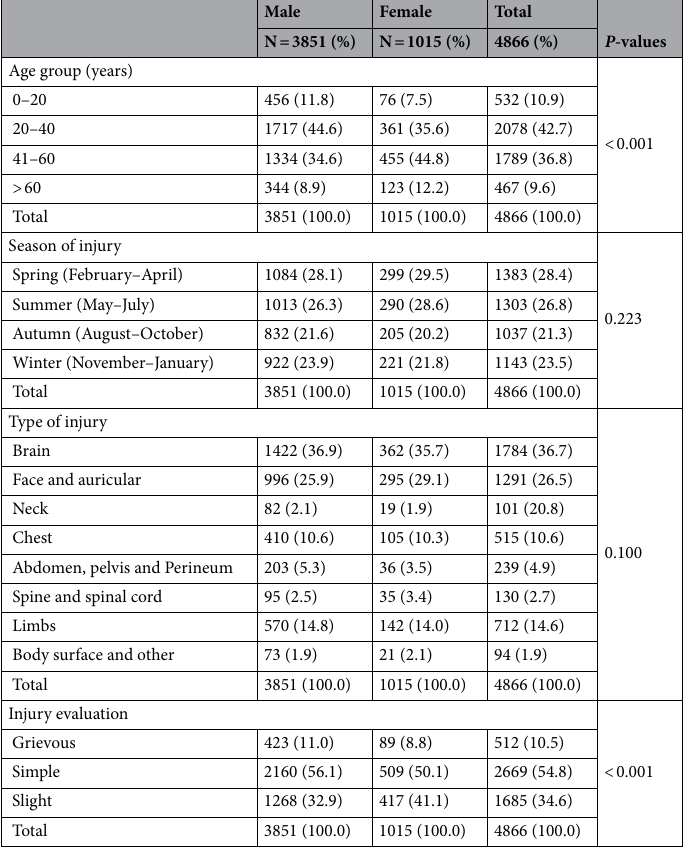
Table 1. Injury cases detected in Sichuan Province, China, from January 2014 to December